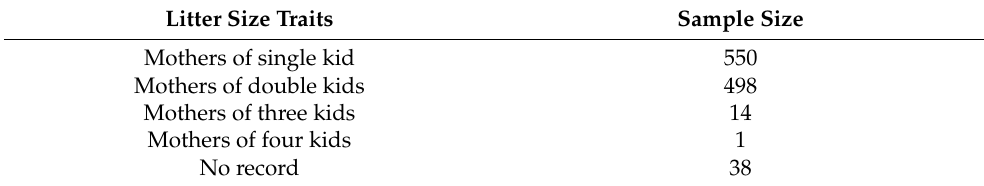
Table 1. The Phenotypic Distribution of Ewes with Different Litter sizes.